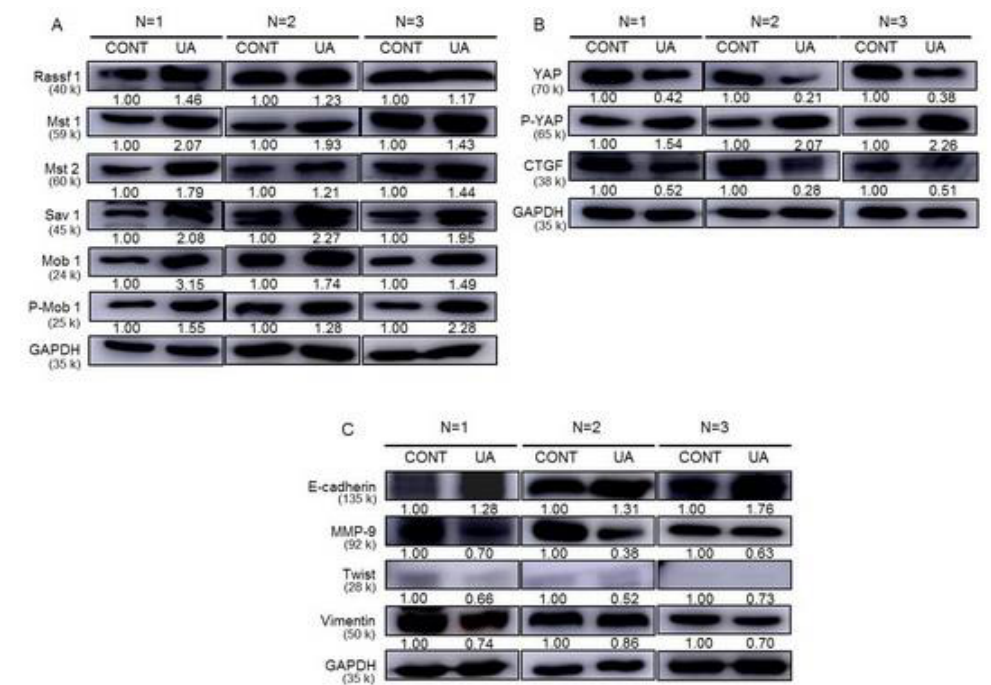
Figure 9. Effects of UA on Hippo pathway-related proteins and metastasis-related proteins in gastric tumors of xenograft mice. ( A ) Western blot data showing the protein expression of Rassf1, Mst1, Mst2, Mob1, p-Mob1, and Sav 1 in tumor tissues from vehicle-treated controls and UA-treated xenografts. ( B ) The expressions of CTGF, YAP, and p-YAP proteins were detected through Western blot analysis in tumor tissues from xenografts. ( C ) The tumor tissues were analyzed for metastasis-related proteins, including E-cadherin, MMP-9, Twist, and Vimentin. GAPDH was used as the internal control. Sav 1, salvador homolog 1; MMP-9, Matrix metallopeptidase 9.